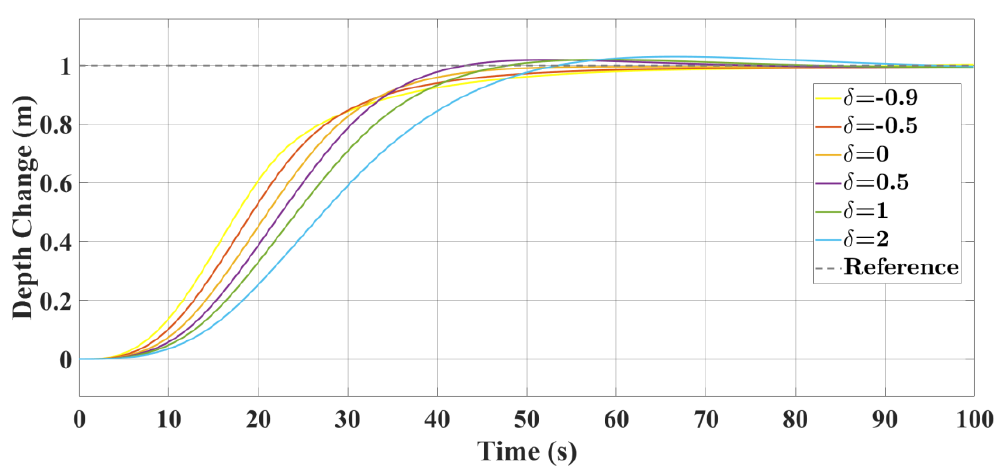
Figure 21. Hovering control responses under different levels of modeling errors.